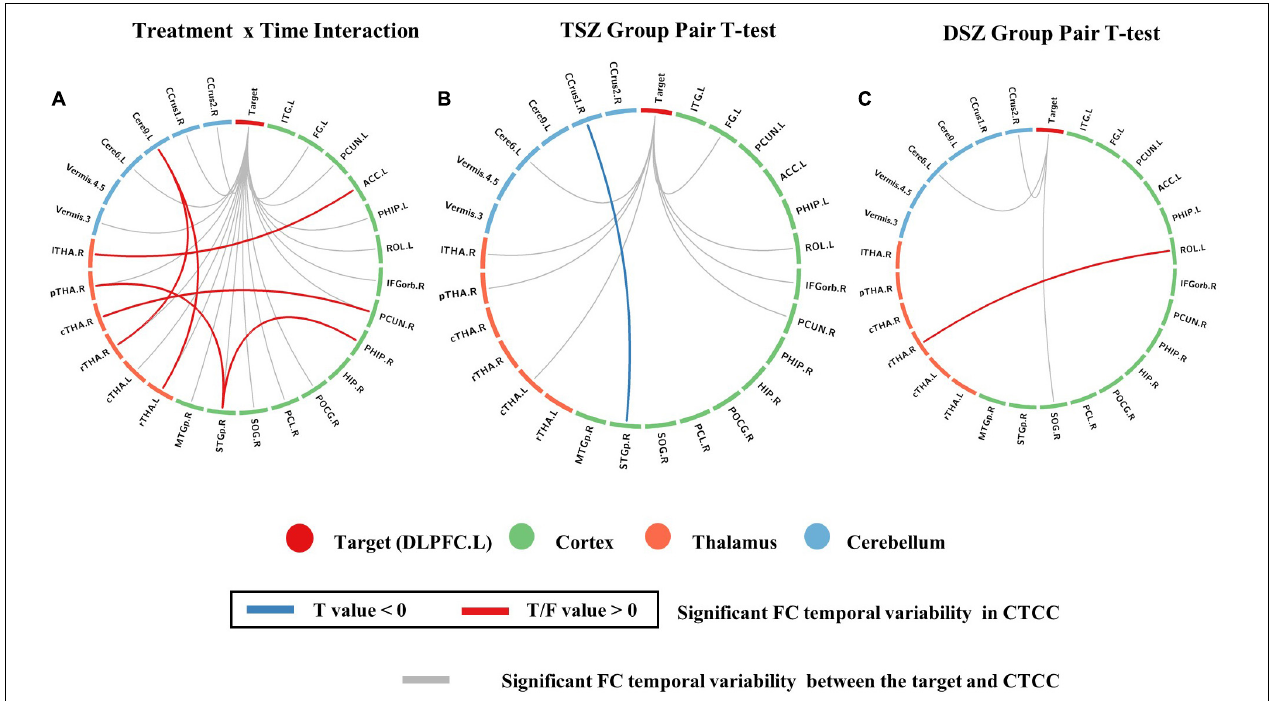
FIGURE 2 | Regions with significant differences in ROI-wise functional connectivity (FC) temporal variability between post- and pre-rTMS interventions. (A) ROIs with significant treatment and time interaction effects in repeated measures ANCOVA. (B) The paired t -test of the TSZ group showed a significant difference between post- and pre-rTMS interventions. (C) The paired t- test of the DSZ group showed a significant difference between post- and pre-rTMS interventions. The threshold was set as p <